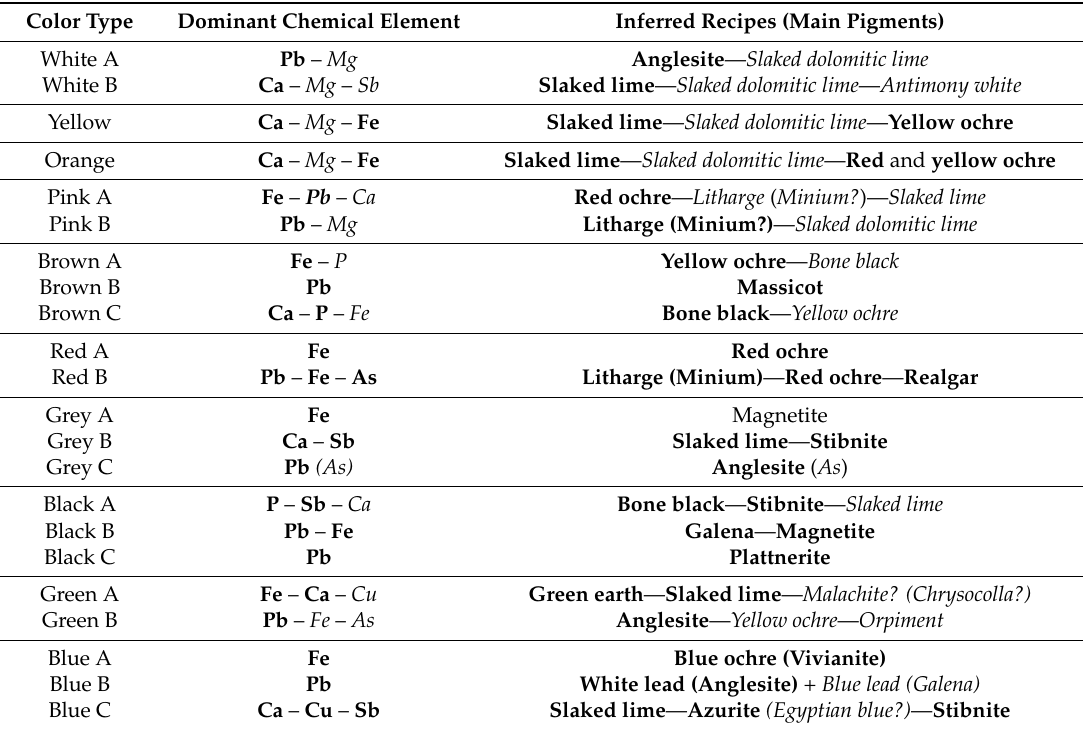
Table 2. The prevalent elements and the inferred recipes used for the fresco paints. The predominant compounds are in bold, and the subordinated compounds are in italics.